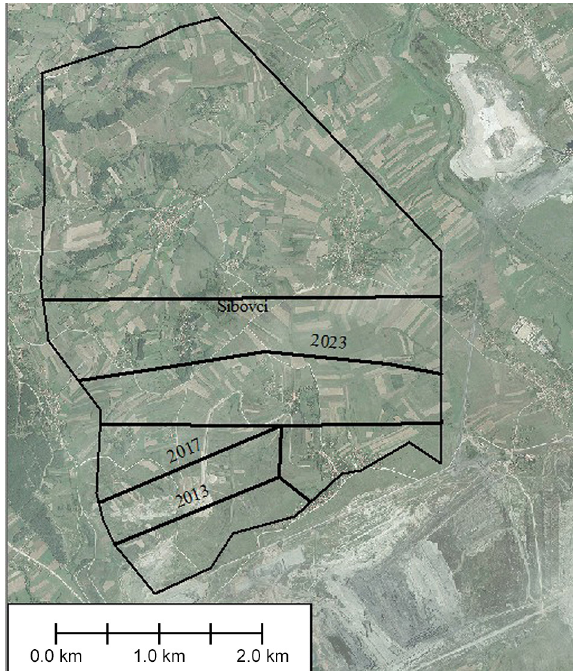
Fig. 9. The future extension of a coal mine in the Kosovo Plain. Source: V.